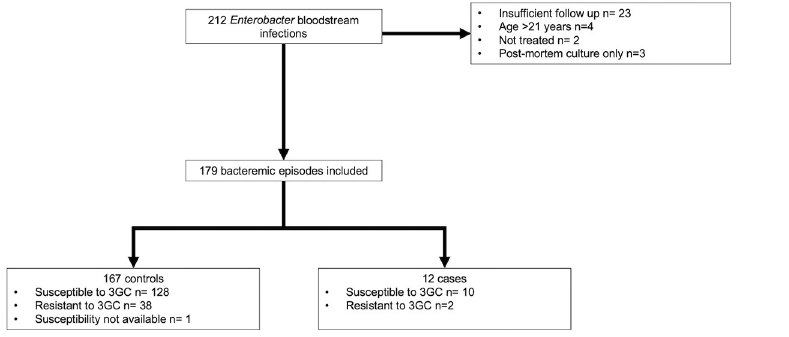
Fig 1. Study selection flowchart. 3GC, third generation cephalosporin.